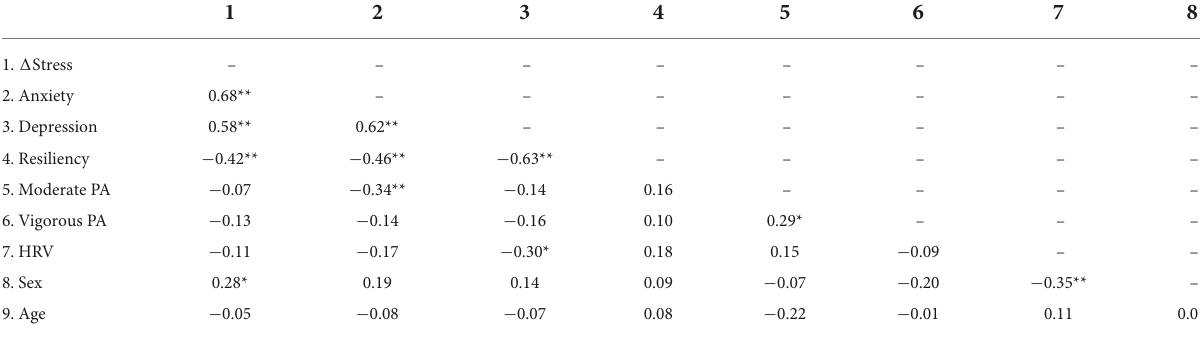
TABLE 3 Bivariate correlations.